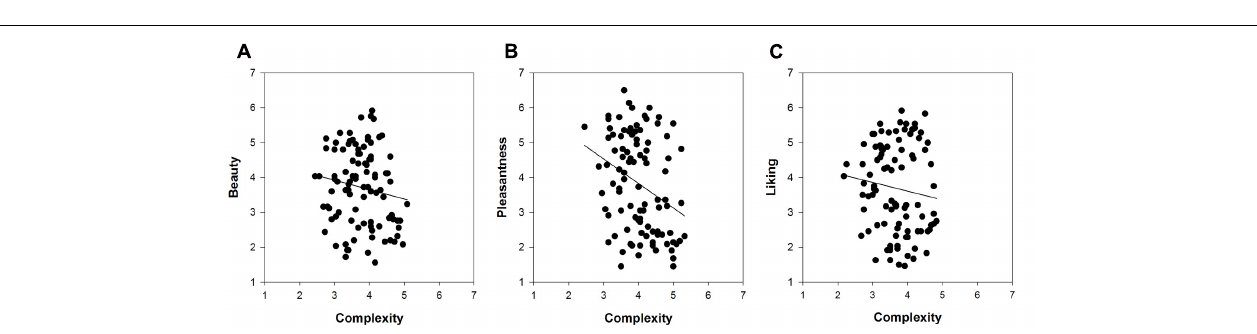
FIGURE 2 | The relationships between complexity and the three measures of hedonic tone for 96 IAPS pictures: (A) beauty, (B) pleasantness, and (C) liking.